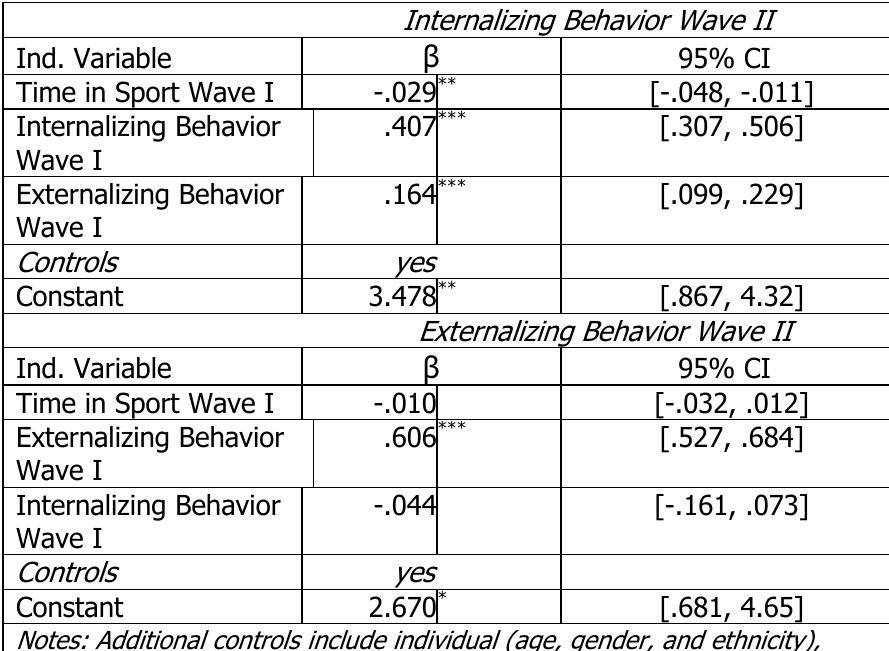
Regression Coefficients for Predicting Problem Behavior Scores Internalizing Behavior Wave